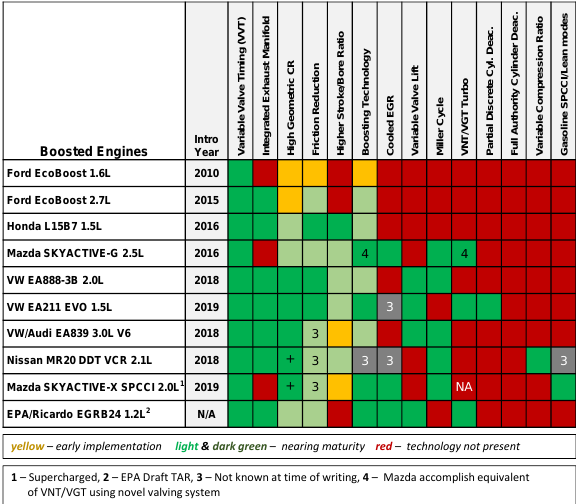
Fig. 2. Combustion engines technology upgrades and implementation status [10] The Institute of Combustion Engines and Powertrains of Poznan University of Technology has a single-cylinder research engine AVL 5804, part of a dynamometer bench.